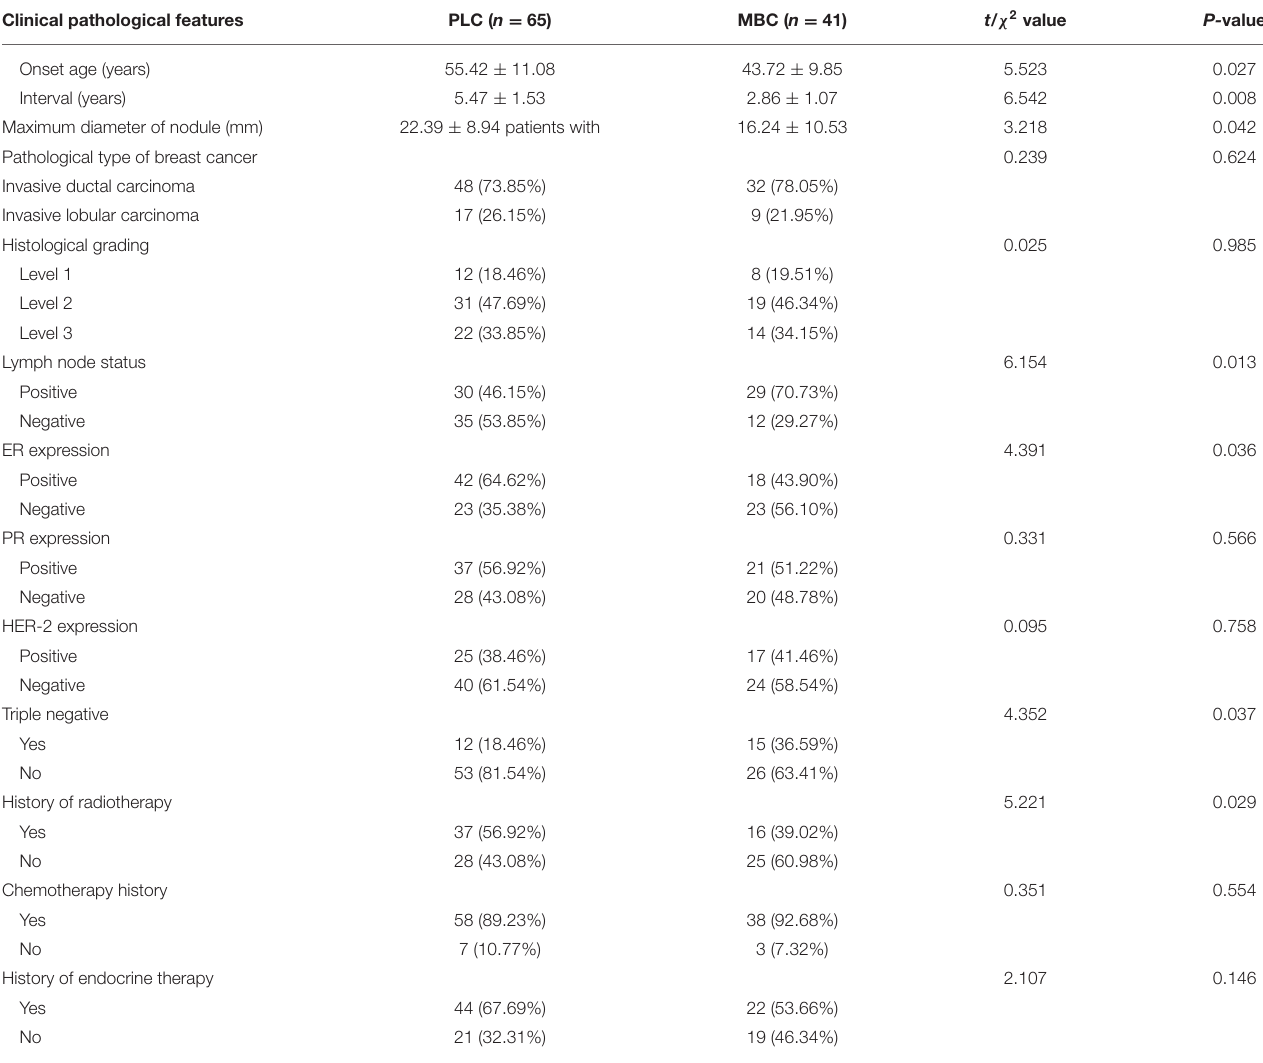
TABLE 1 | Comparison of clinical characteristics between patients with PLC and MBC disease ( n , ¯ x ± s). Clinical pathological